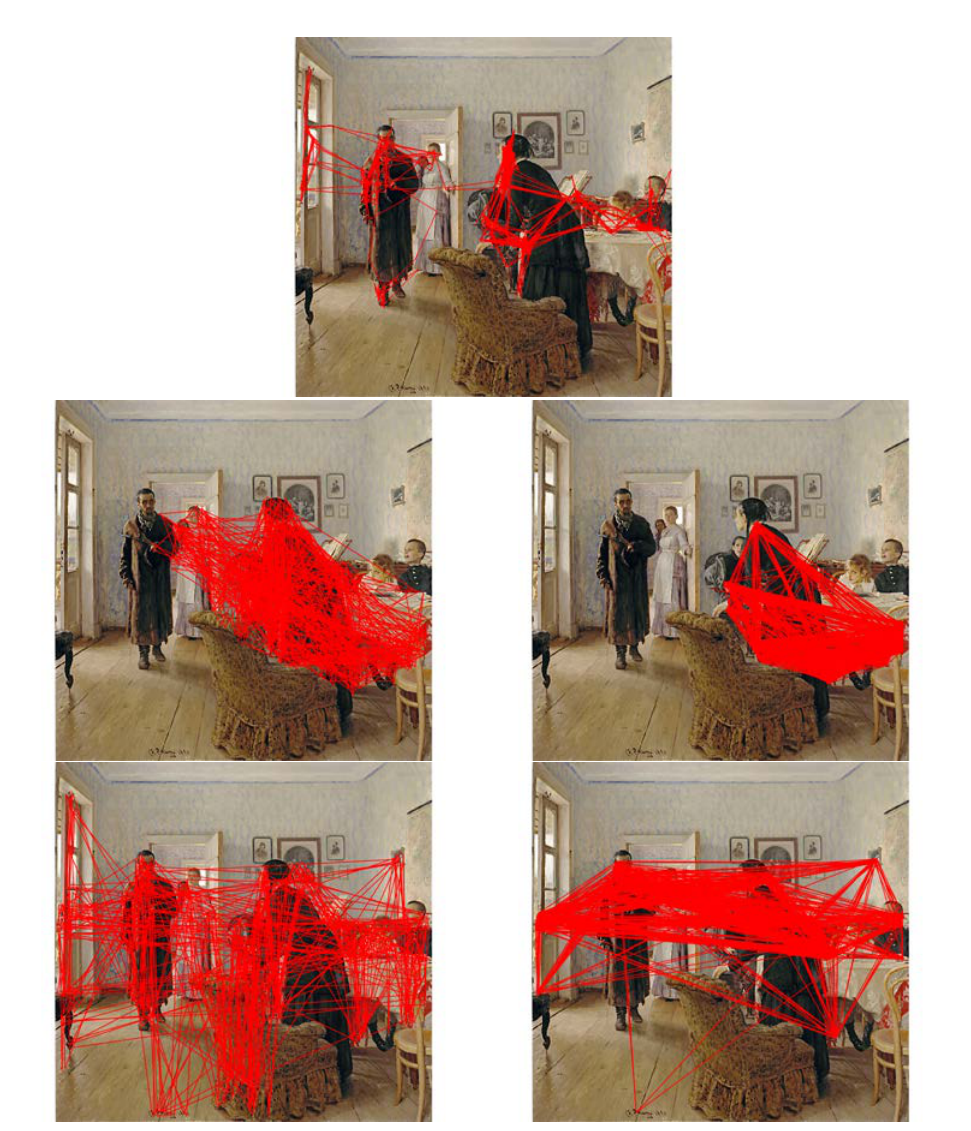
Figure 16. 720 fixations on the Repin painting for the following test configurations. Top: The scanpath generated by STAR on the Repin painting. In a manner not too dissimilar from the human scan paths of Figure 12 (panel 1), Figure 13 and Figure 14, it is easy to see 'interest' in certain structures of the image. Middle Left: The scanpath generated by the CAS algorithm on the Repin painting. Middle Right: The scanpath generated by the revised CAS algorithm that includes the same decay of IOR as STAR. Bottom Left: The scanpath generated by the AIM algorithm on the Repin painting. Bottom Right: The scanpath generated by the revised AIM algorithm that includes the same decay of IOR as